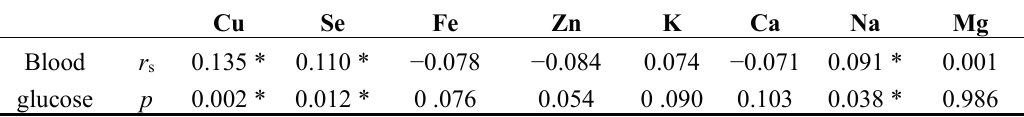
Table 4. Correlation between blood glucose levels and hair element